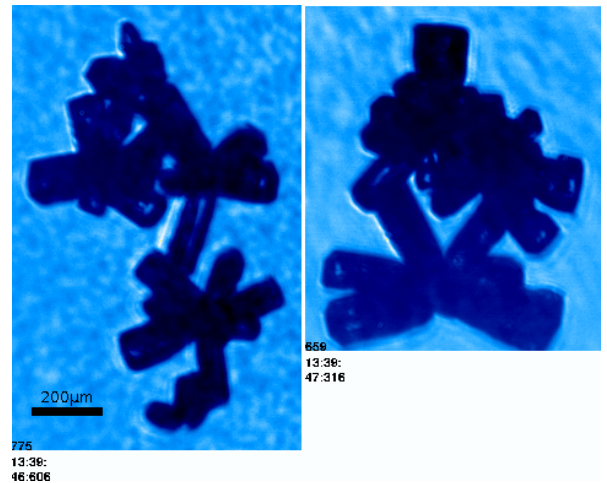
Figure 8. CPI ice crystal images from run 5. Time stamps are indi- cated below each